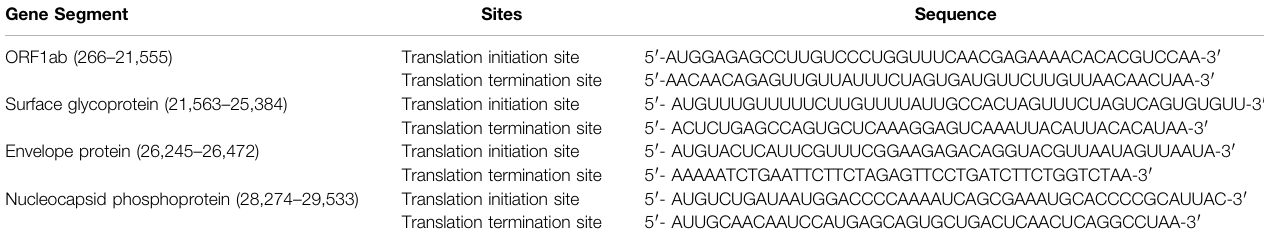
TABLE 2 | Selected sequence of initiation and termination sites of target protein mRNAs from SARS-CoV-2 whole genome. Gene Segment Sites